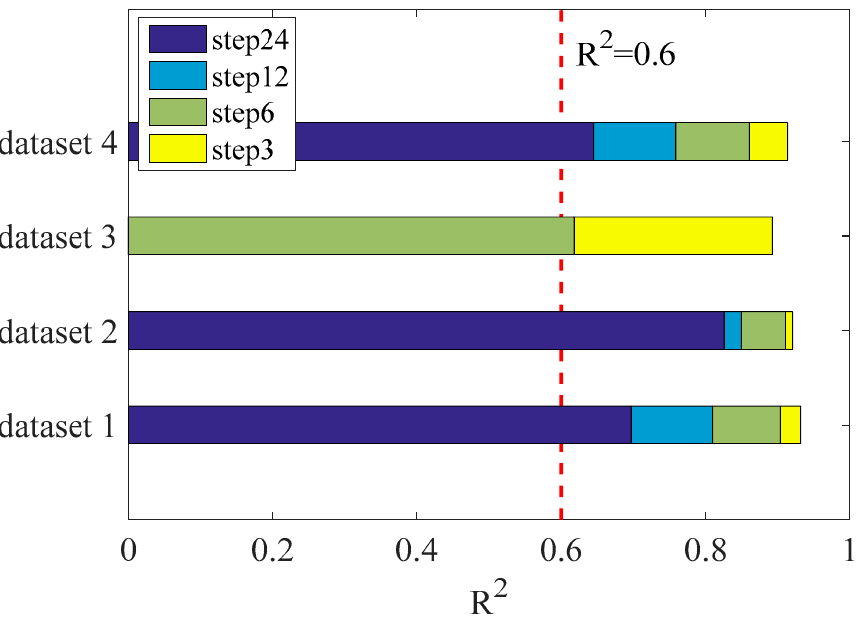
ffi cient of determination for the multi-step prediction under four Figure 16. Coefficient of determination for the multi-step prediction under four datasets. Figure 16. Coe